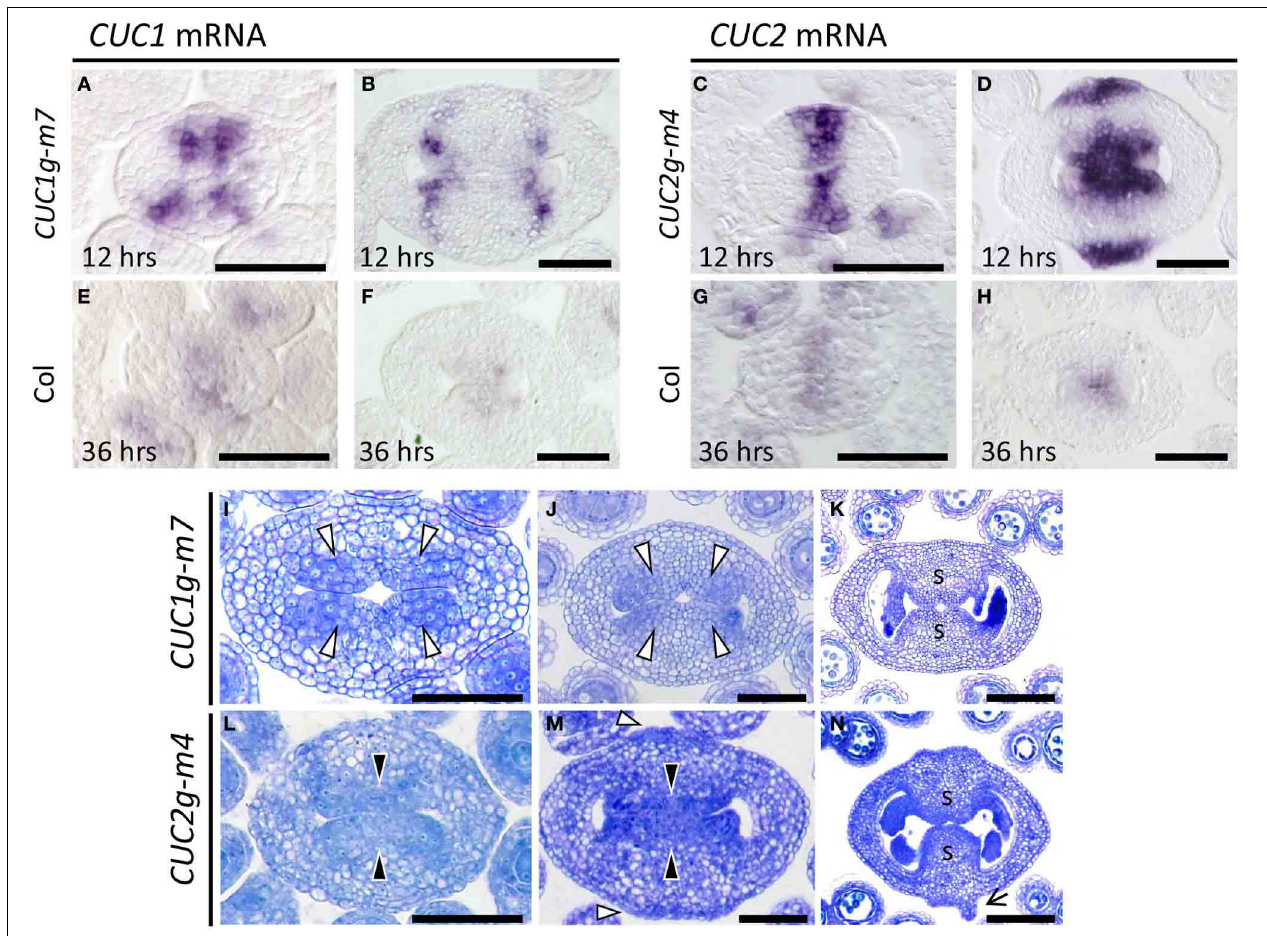
FIGURE 6 | CMM development in CUC1g-m7 and CUC2g-m4 . (A–H) In situ hybridization on transverse sections from developing gynoecia of CUC1g-m7 (A,B) , CUC2g-m4 (C,D) and wild type Col (E–H) probed with CUC1 (A,B,E,F) and CUC2 (C,D,G,H) . Staining reaction was carried out for 12h in CUC1g-m7 (A,B) and CUC2g-m4 (C,D) , and for 36h in Col (E–H) . Sections are prepared from gynoecia at stage 6 (A,C,E,G) and